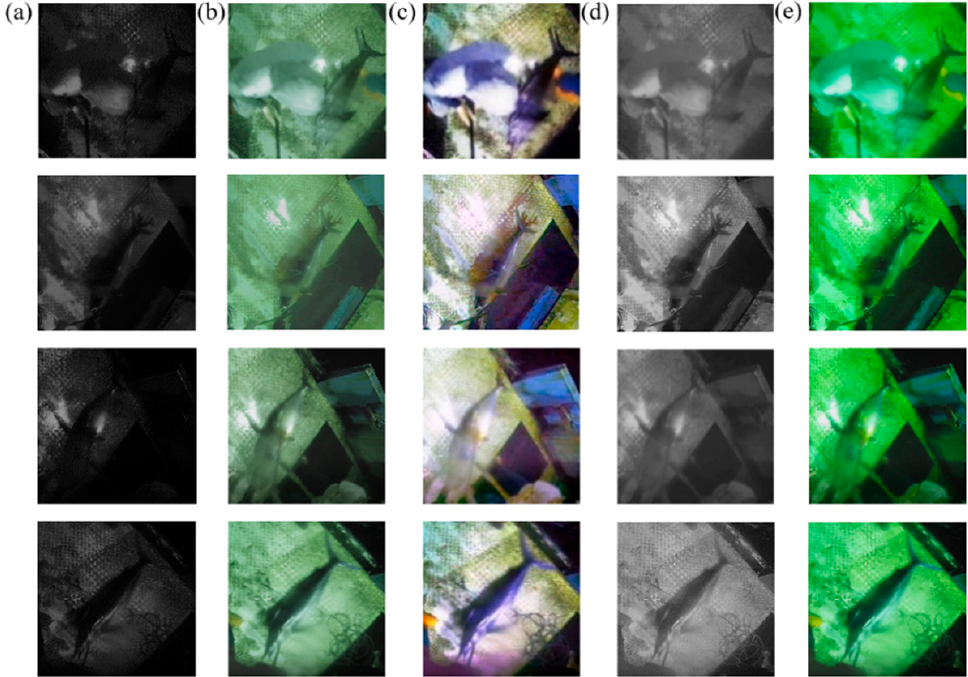
Figure 4. Effect of different data augmentation. ( a – e ), respectively, represent original image, satura- tion adjustment, histogram equalization, gamma correction and improved multi-scale retinex. Table 3. Comparison of image quality between before and after image augmentation. among Tuna-YOLO, YOLOv3 and DenseNet201 after training. The best mAP was based on the improved multi-scale Retinex algorithm (Table 4). Table 4. mAP of network model in different augmentation algorithms. Image